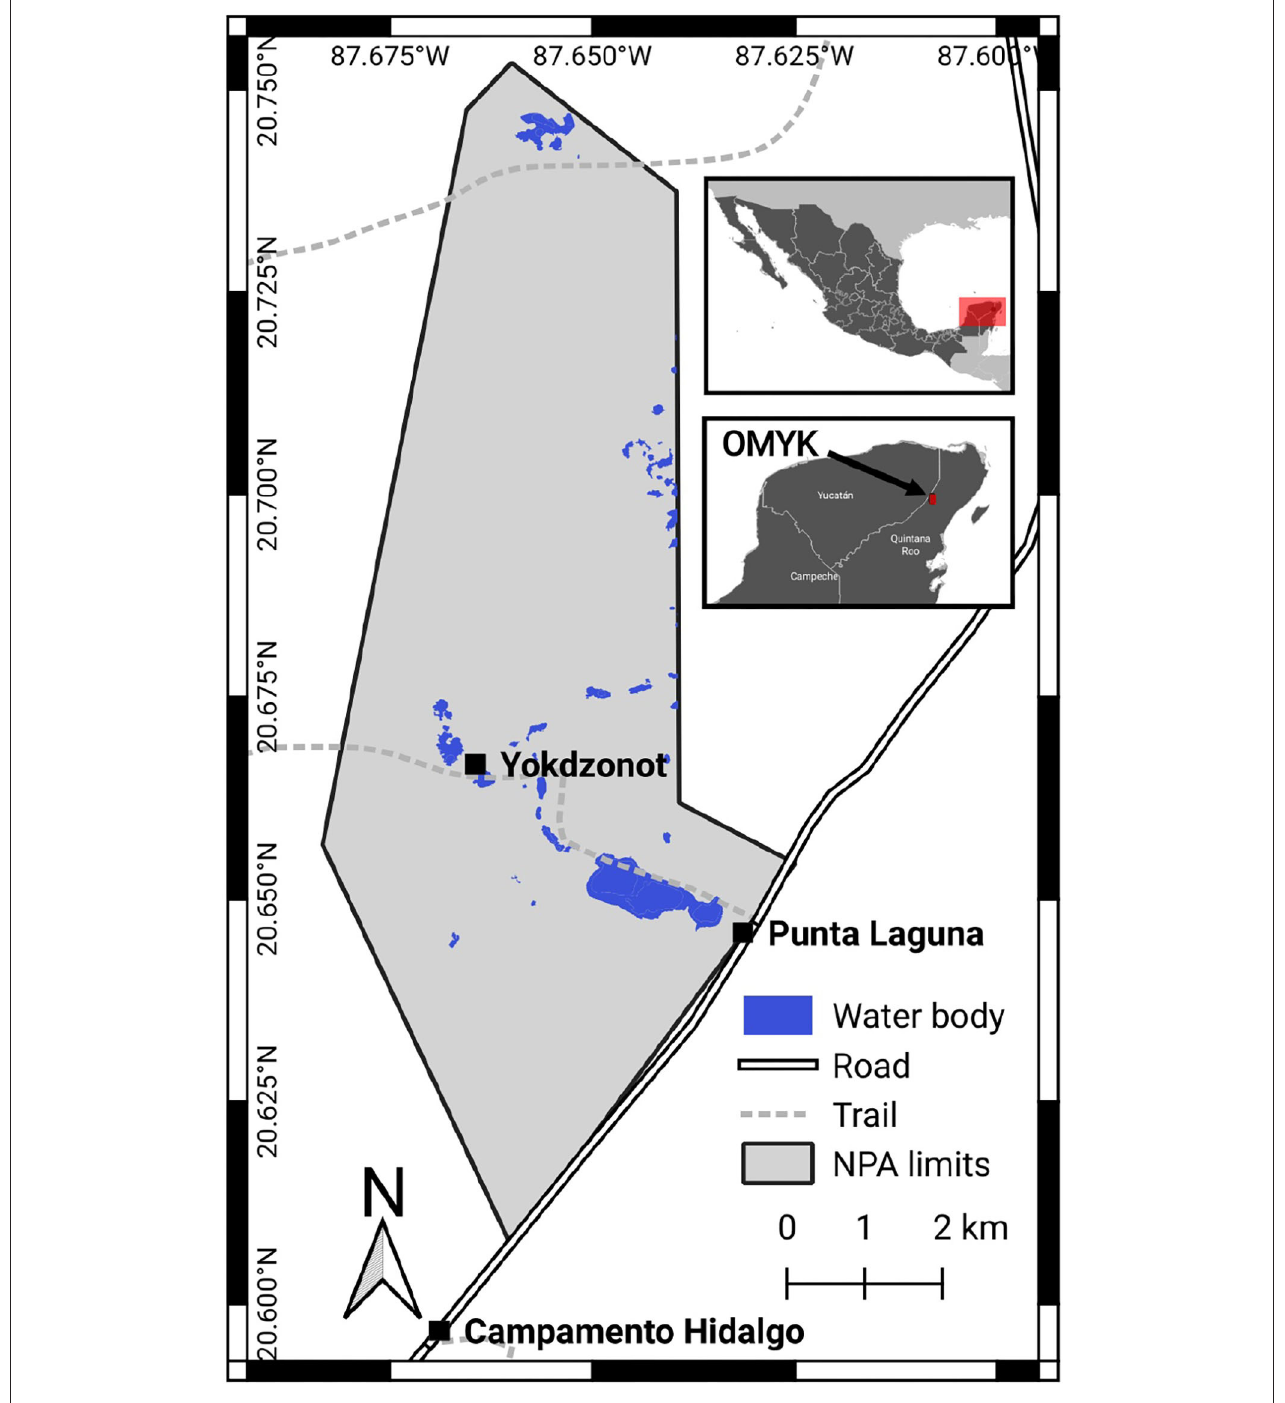
FIGURE 1 | Location of the Natural Protected Area Otoch Ma’ax Yetel Kooh (OMYK) showing the main locations mentioned in the text.